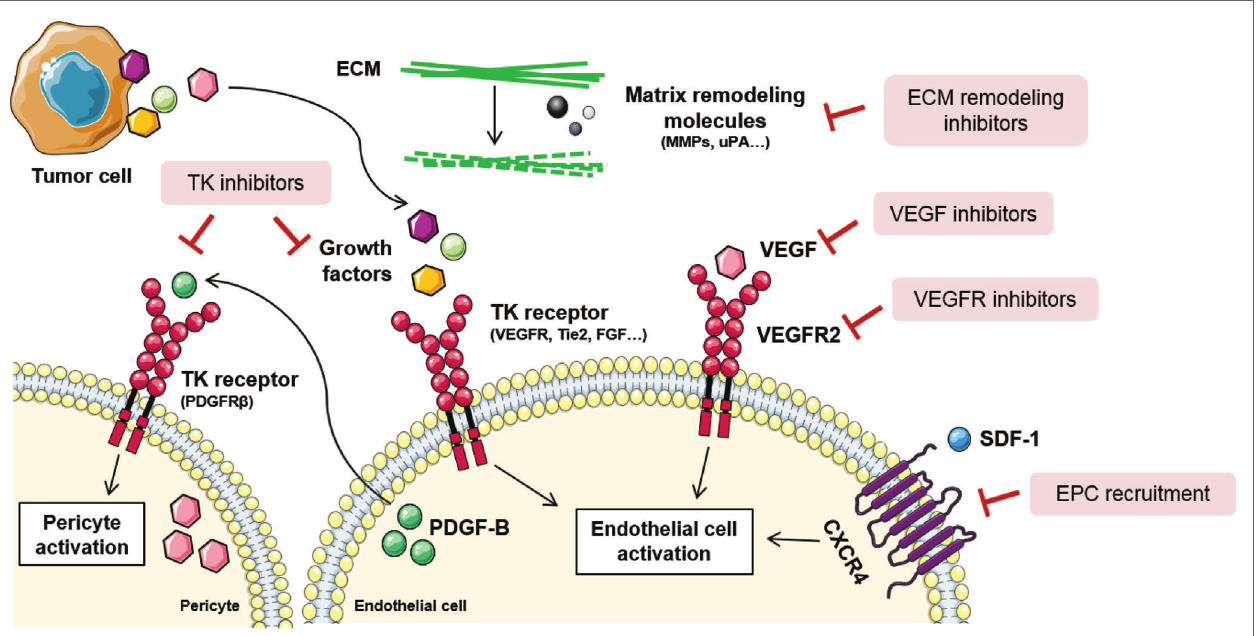
FigURe 3 | Tumor angiogenesis inhibition strategies. Due to the complexity of tumor angiogenesis, it can be inhibited at different levels. Direct vessel signaling inhibition approaches include VEGF ligand inhibitors, VEGFR receptor inhibitors, and other growth factors inhibitors released by stromal or tumor cells. Other examples are tyrosine kinase (TK) inhibitors, that block endothelial and pericyte cell activation, thus blocking their proliferation, migration, and survival. Novel antiangiogenic strategies are directed toward endothelial progenitor cell (EPC) recruitment inhibition, via stromal-derived factor 1 (SDF-1)/C-X-C chemokine receptor type 4 (CXCR4) signaling blockade, and extracellular matrix (ECM) remodeling inhibition. Figure was created using Servier Medical Art according to a Creative Commons Attribution 3.0 Unported License guidelines 3.0 (https://creativecommons.org/licenses/by/3.0/). Simplification and color changes were made to the original